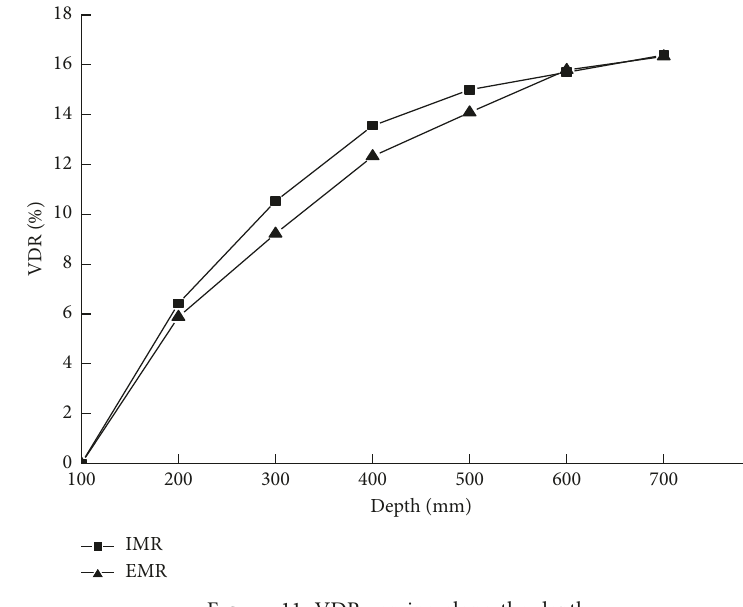
Figure 11: VDR varying along the depth.